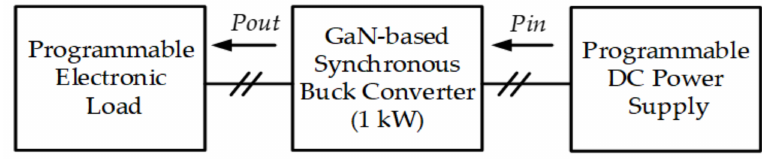
Figure 18. The system block diagram of the efficiency